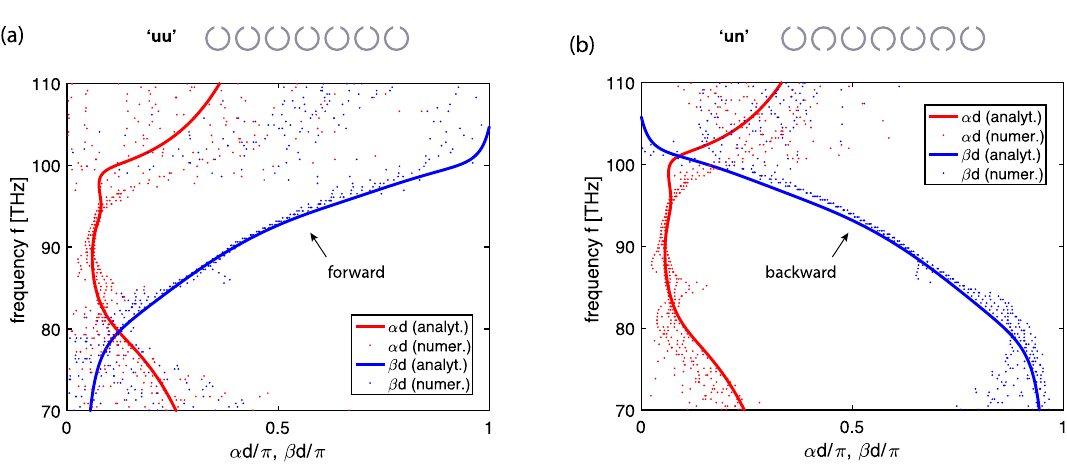
Figure 7. EI dispersion relations for the ‘uu’ ( a ) and the ‘un’ ( b ) array. Red: attenuation constant α vs. ω , blue: propagation constant β vs. ω . Analytical model (solid lines) and numerical data